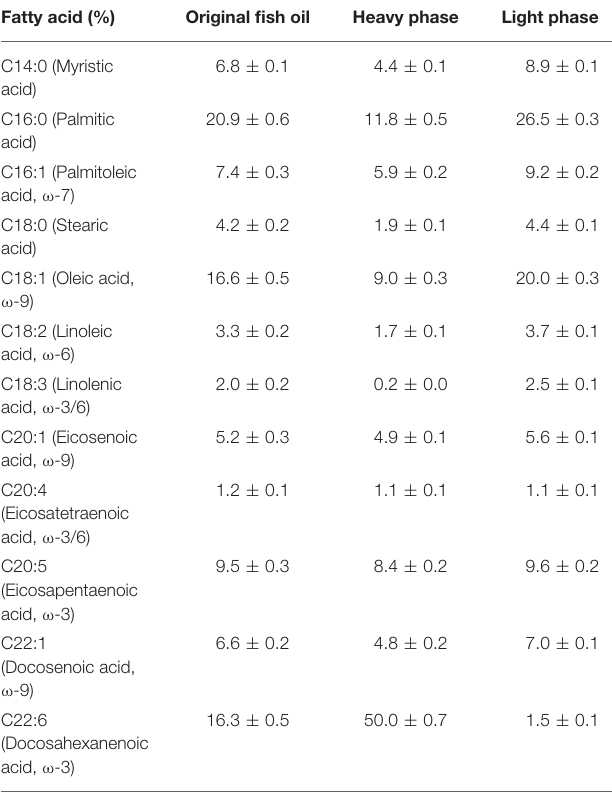
TABLE 3 | FA composition of heavy phase and light phase. Fatty acid (%) Original fish oil Heavy phase Light phase